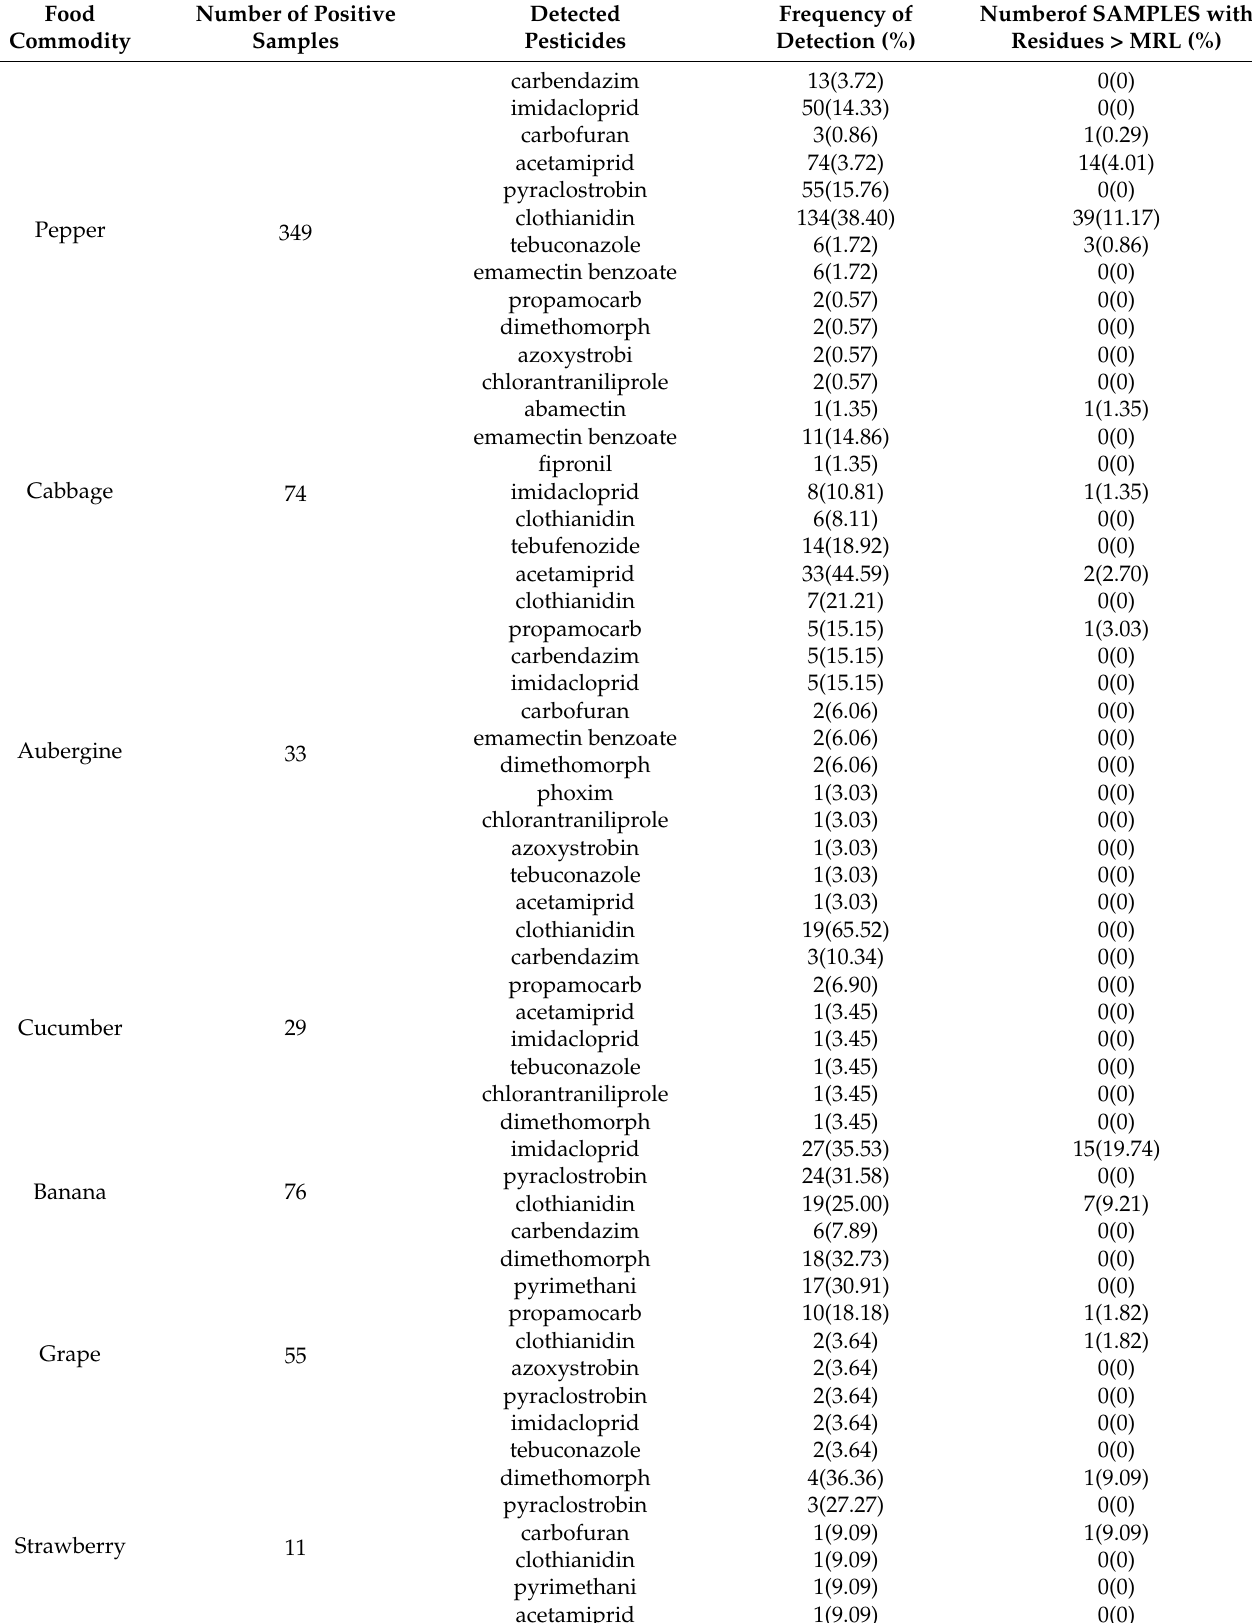
Table 5. Type of pesticides detected and frequency of detection in tested food